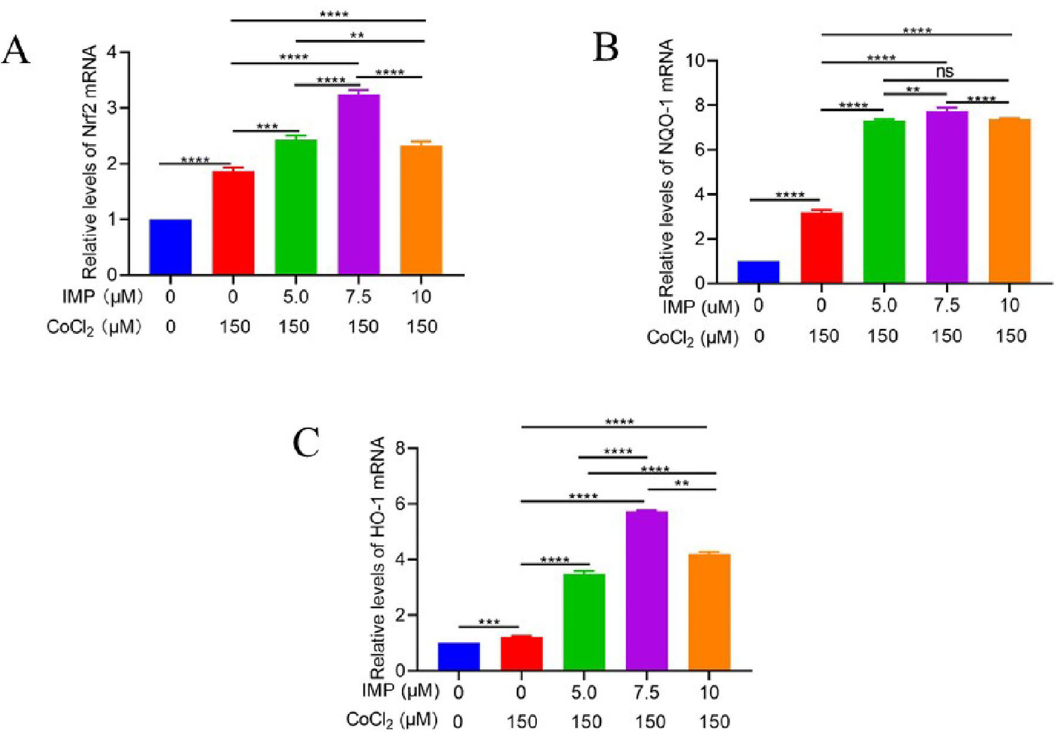
Figure 7. The effects of IMP on the expression of Nrf2, NQO-1, HO-1 mRNA after 24 h intervention in hippocampal neuronal cells. ( A ) Nrf2 mRNA, ( B ) NQO-1 mRNA, ( C ) HO-1 mRNA. (n = 6 for every group, ns, there was no statistical difference, ** P < 0.01, *** P < 0.001, **** P < 0.0001).